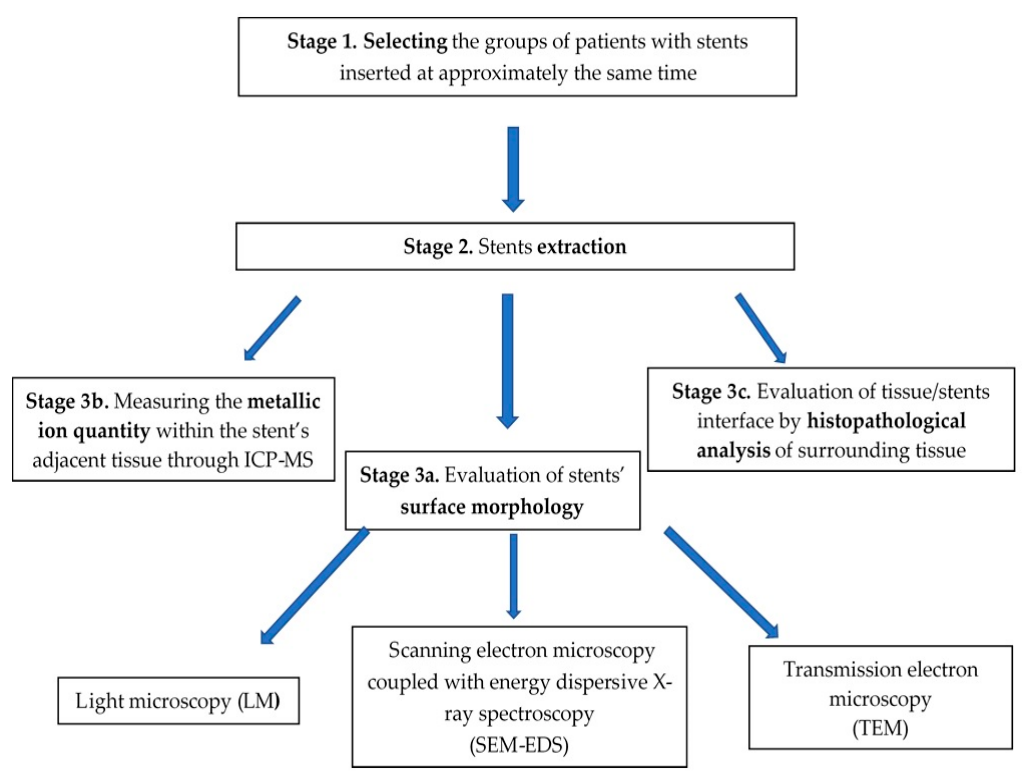
Figure 1. Schematic representation of research design.